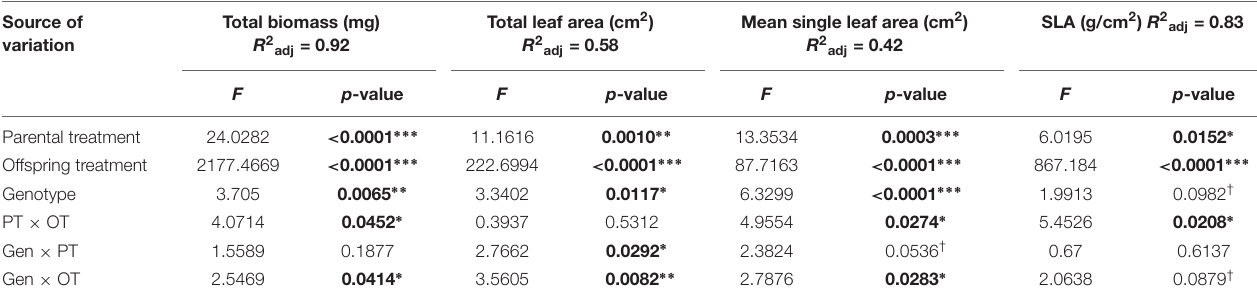
TABLE 1 | Results of significance tests for effects of shade versus sun parental treatment (PT), shade versus sun offspring treatment (OT), and genotype (Gen) on seedling traits based on a three-way ANOVA ( N = 184; details in Materials and Methods). Source of